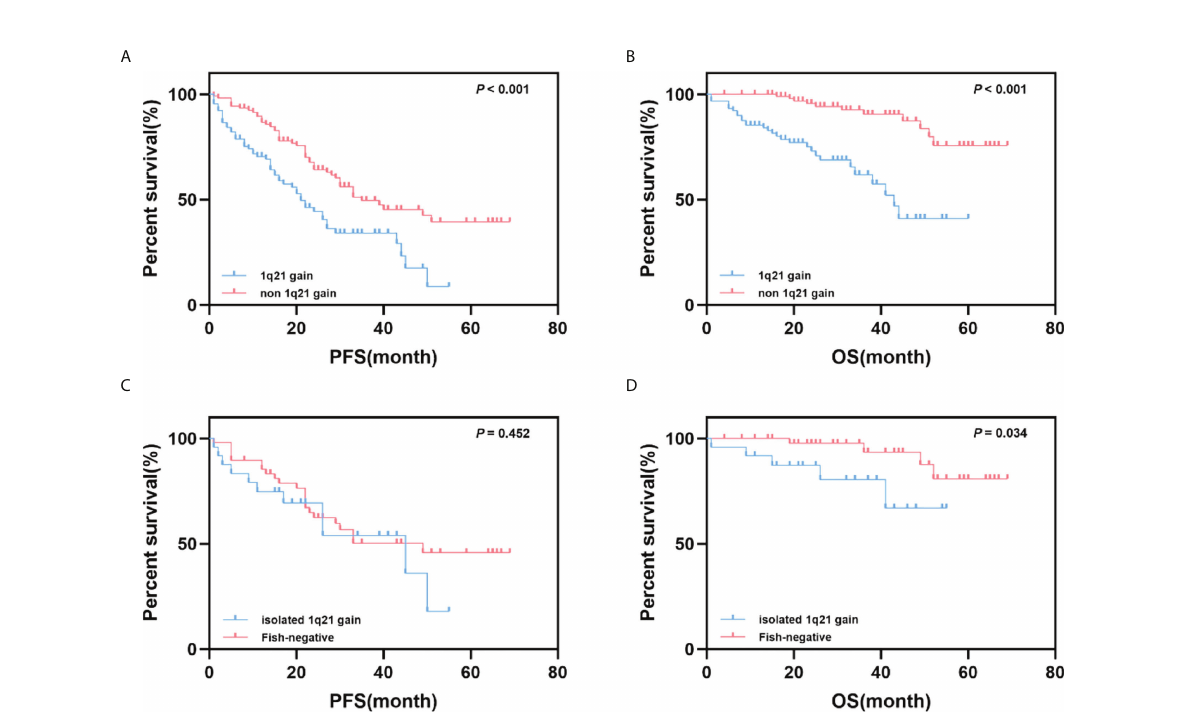
FIGURE 1 Impact of 1q21 gain on PFS and OS. (A, B) Kaplan – Meier curves are shown for PFS and OS for patients with 1q21 gain and without 1q21 gain. (C, D) Kaplan – Meier curves are shown for PFS and OS for patients with 1q21 gain only and with no cytogenetic abnormalities.